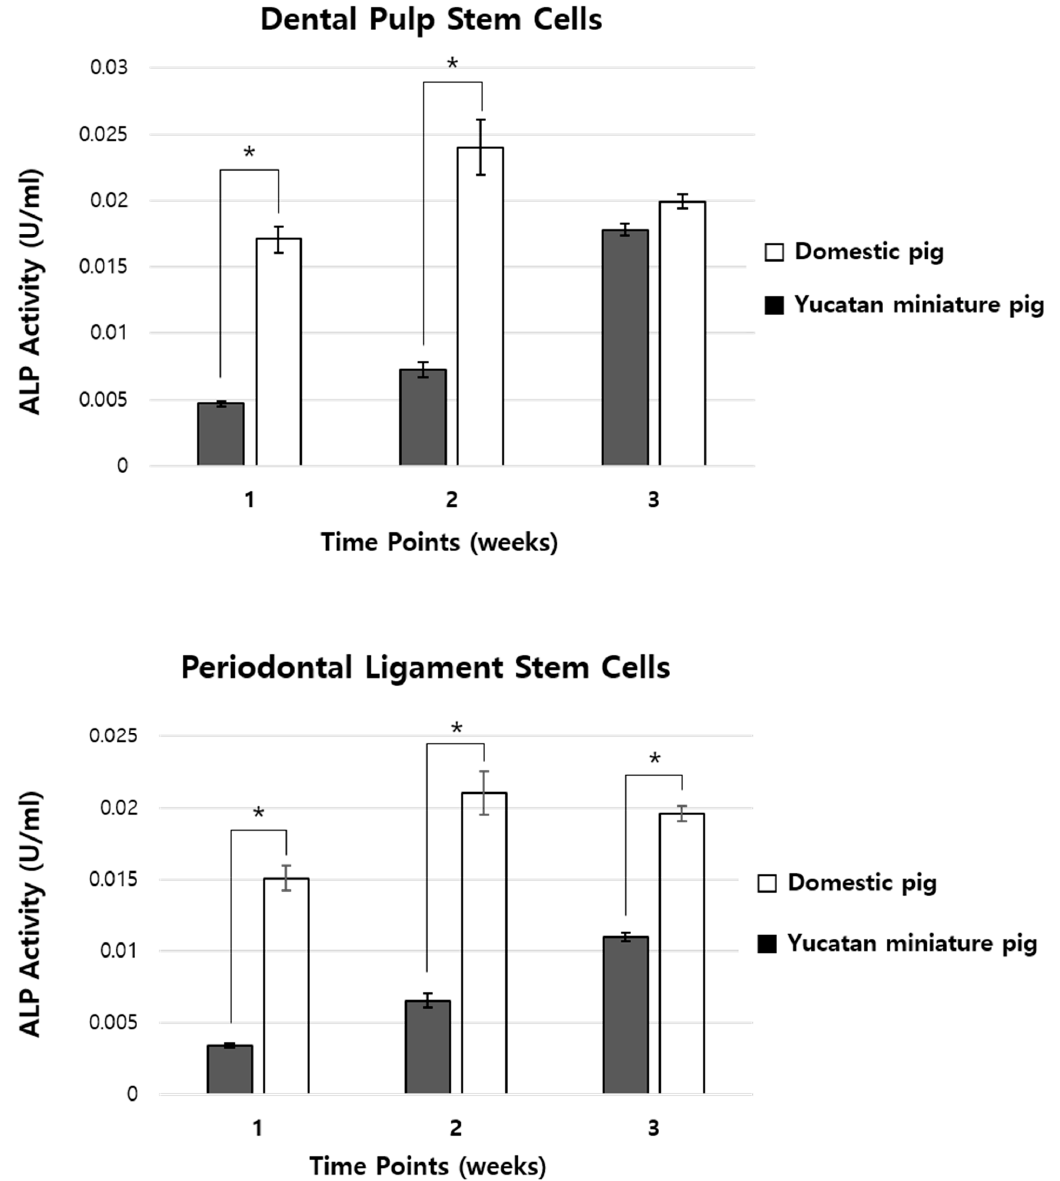
Figure 6. The alkaline phosphatase (ALP) activity of the dental pulp stem cells (DPSCs) and periodontal ligament stem cells (PDLSCs) of the miniature pig breed and the domestic farm pig breed, cultured in osteogenic media at one, two, and three weeks. The ALP activity was significantly lower in the DPSCs and PDLSCs of the miniature pig breed than in the DPSCs and PDLSCs of the domestic farm pig breed (* p < 0.05).